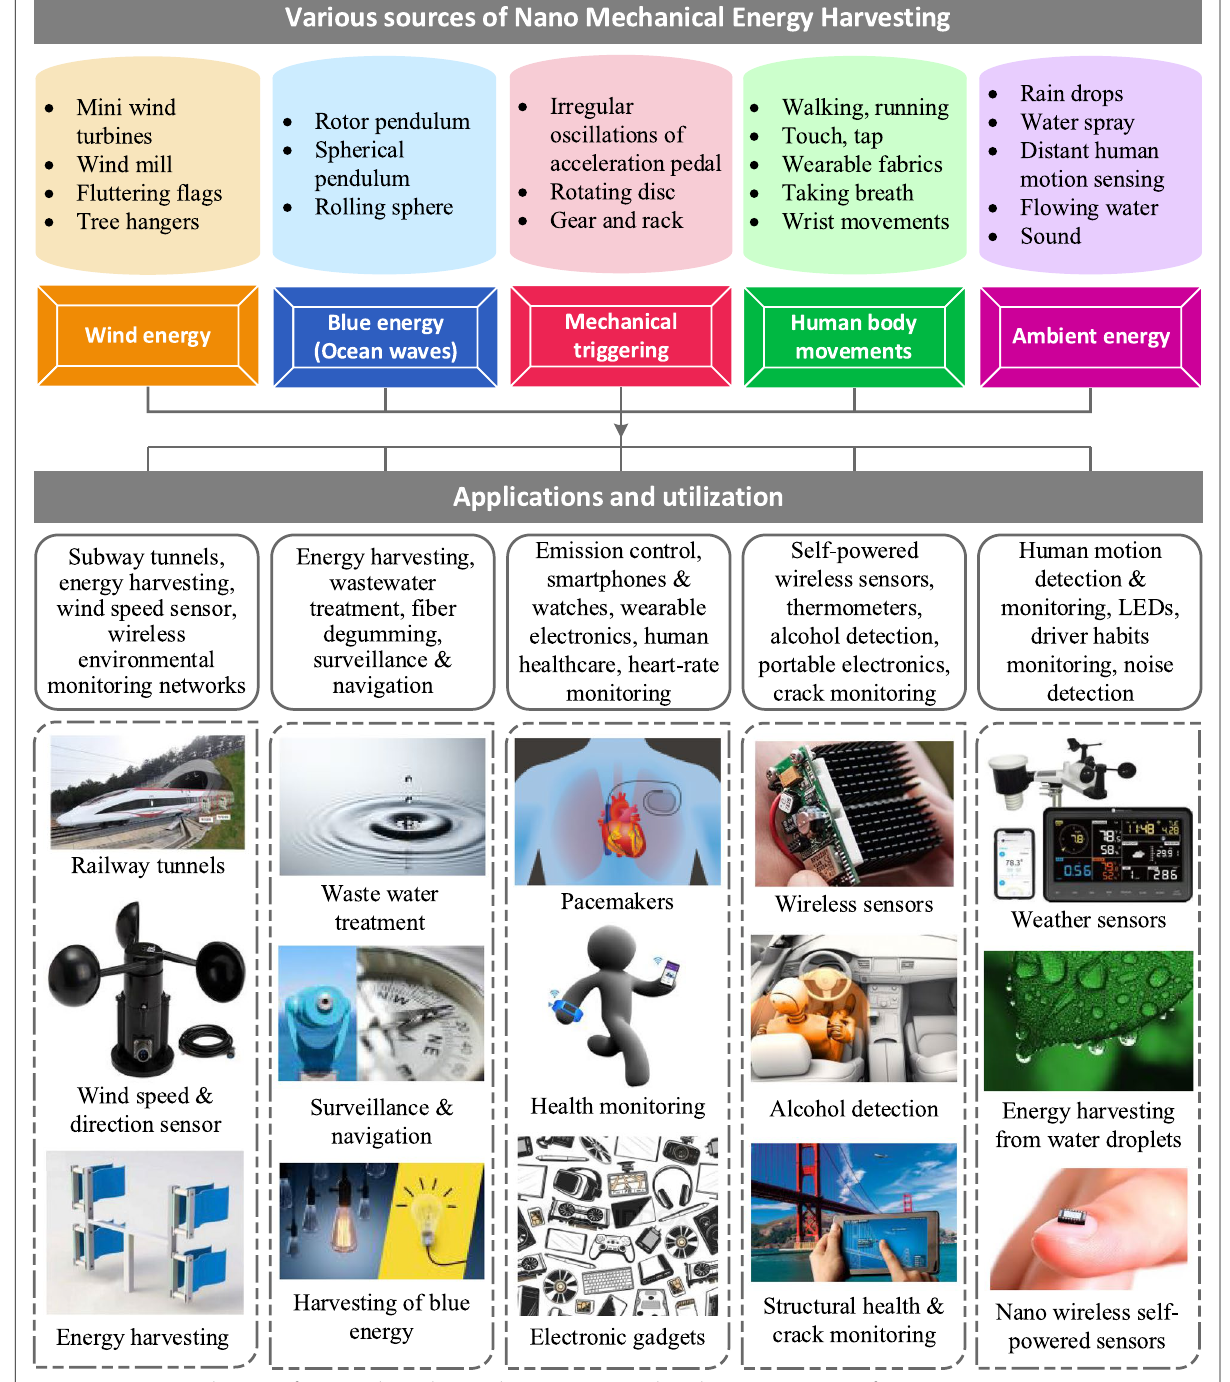
Fig. 14 Emerging applications of nanomechanical energy harvesting systems based on various sources of